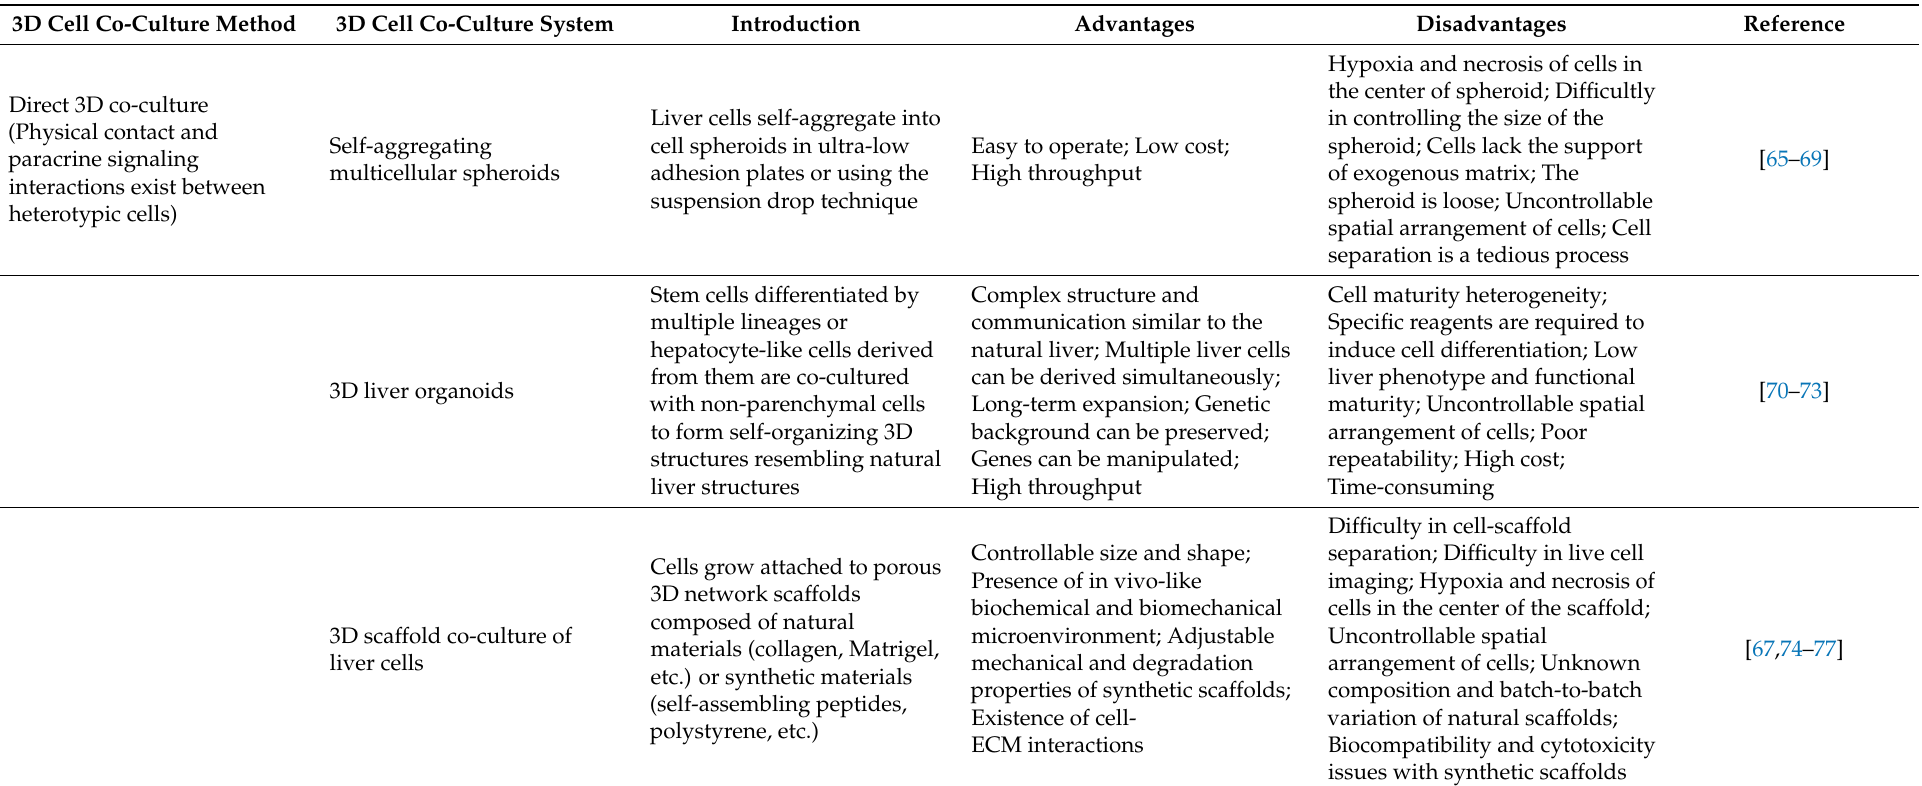
Table 2. Common 3D liver cell co-culture systems for direct 3D co-culture and/or indirect 3D co-culture, and their advantages and